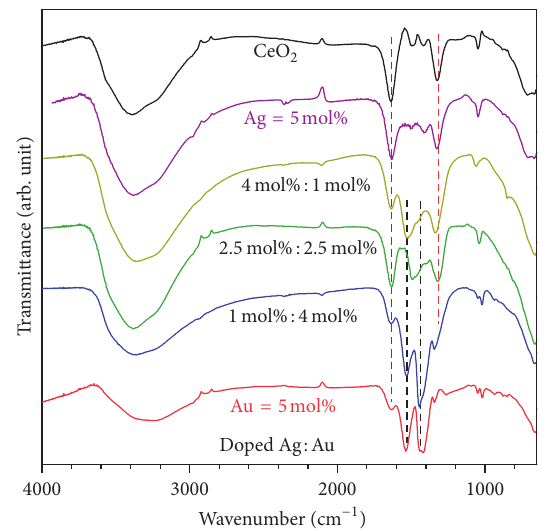
Figure 4: FT-IR spectra of undoped CeO 2 and Au and Ag doped and codoped (5/0, 0/5, 4/1, 2.5/2.5, and 1/4mol.%) CeO 2 .